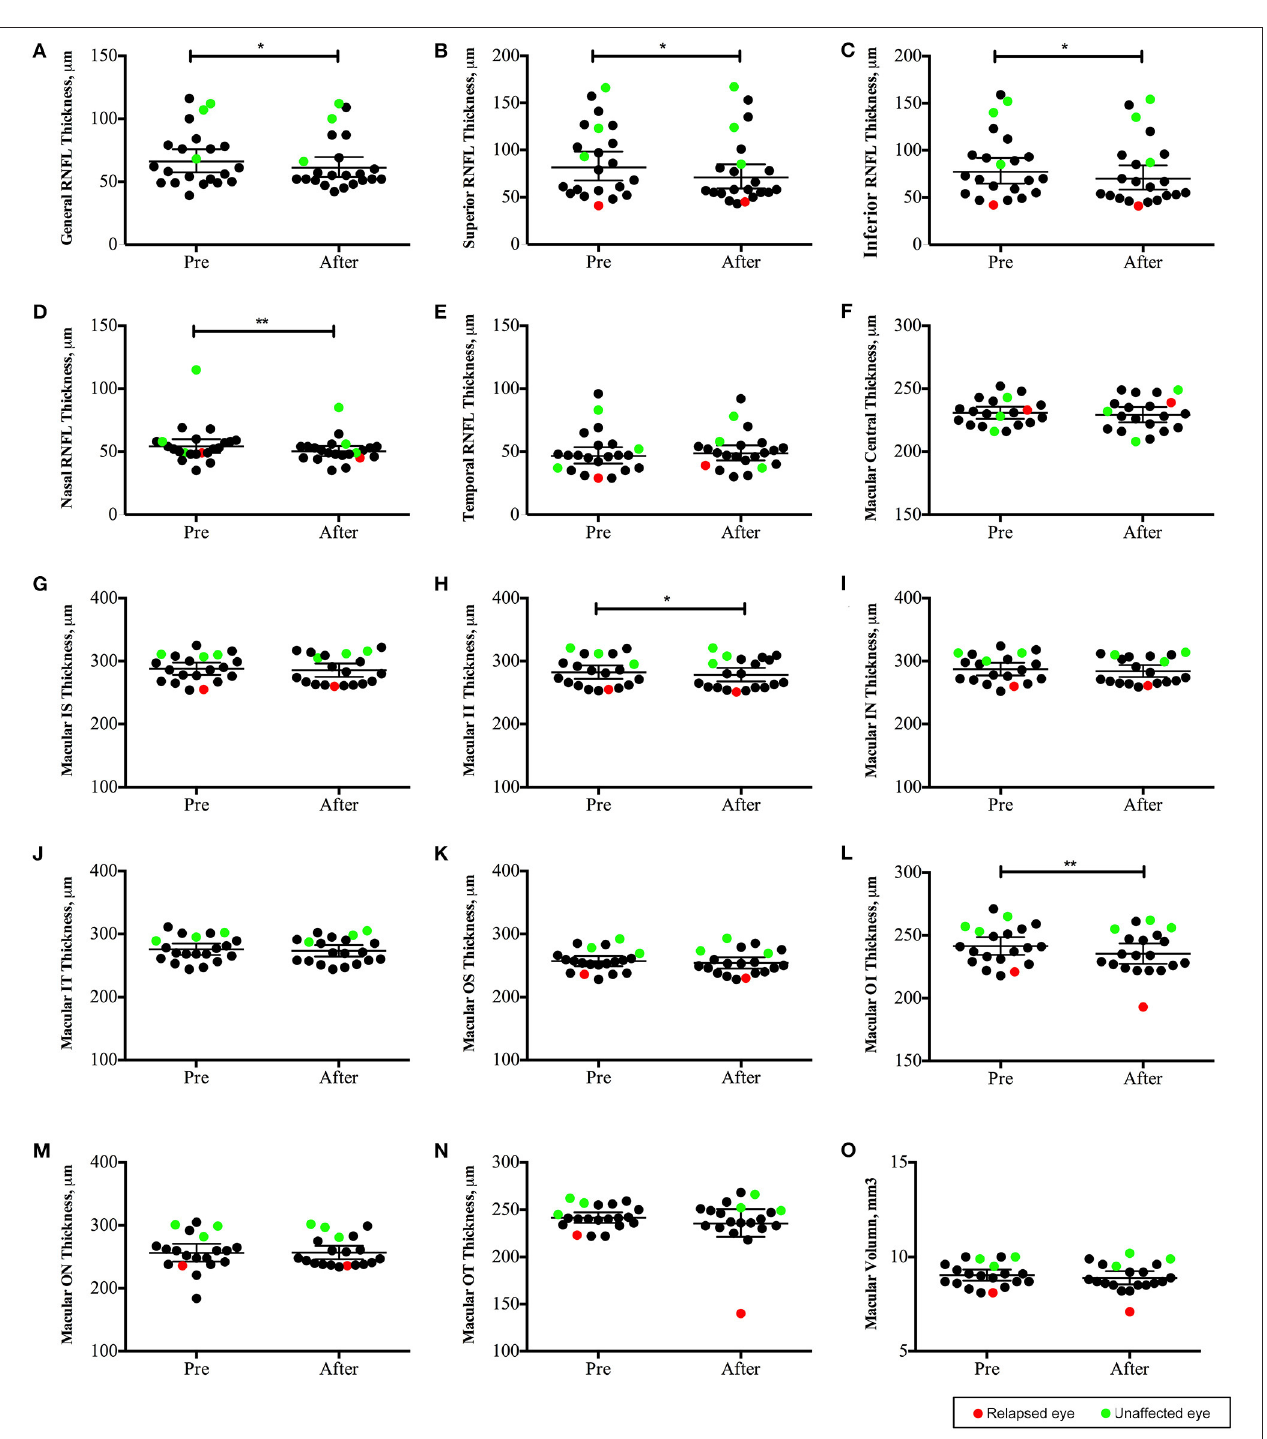
FIGURE 5 | Changes in optic coherence tomography (OCT) parameters in neuromyelitis optica-associated optic neuritis patients followed up for 12 months (22 eyes): The peripapillary retinal nerve fiber layer (pRNFL) was significantly thinner in the superior, inferior and nasal quadrants (B–D) ; the macular neuroretinal thickness was significantly decreased in the inferior quadrant of both the inner and outer rings (H,L) . ** P < 0.01; * P < 0.05. Red points: relapsed eyes; Green point: unaffected eye. IS, superior quadrant of the inner ring; II, inferior quadrant of the inner ring; IN, nasal quadrant of the inner ring; IT, temporal quadrant of the inner ring; OS, superior quadrant of the outer ring; OI, inferior quadrant of the outer ring; ON, nasal quadrant of the outer ring; OT, temporal quadrant of the outer ring).